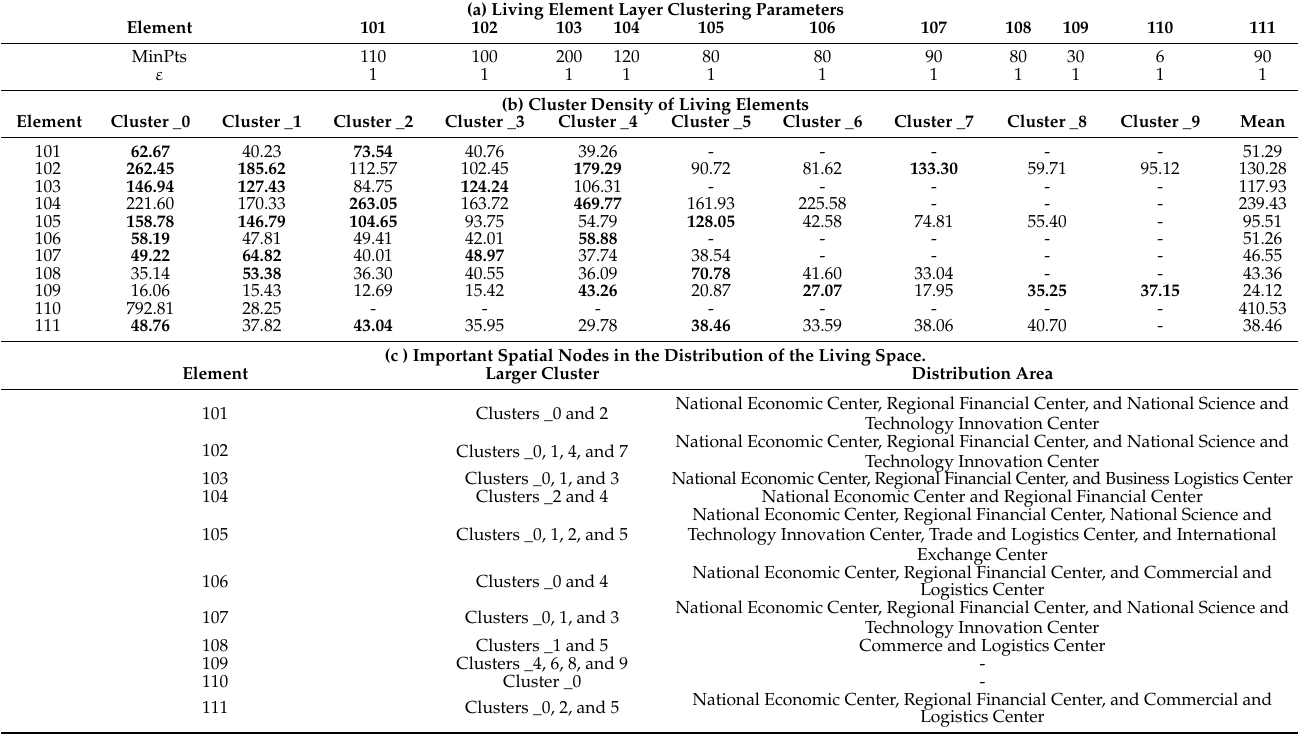
Table 4. Spatial distribution characteristics of living